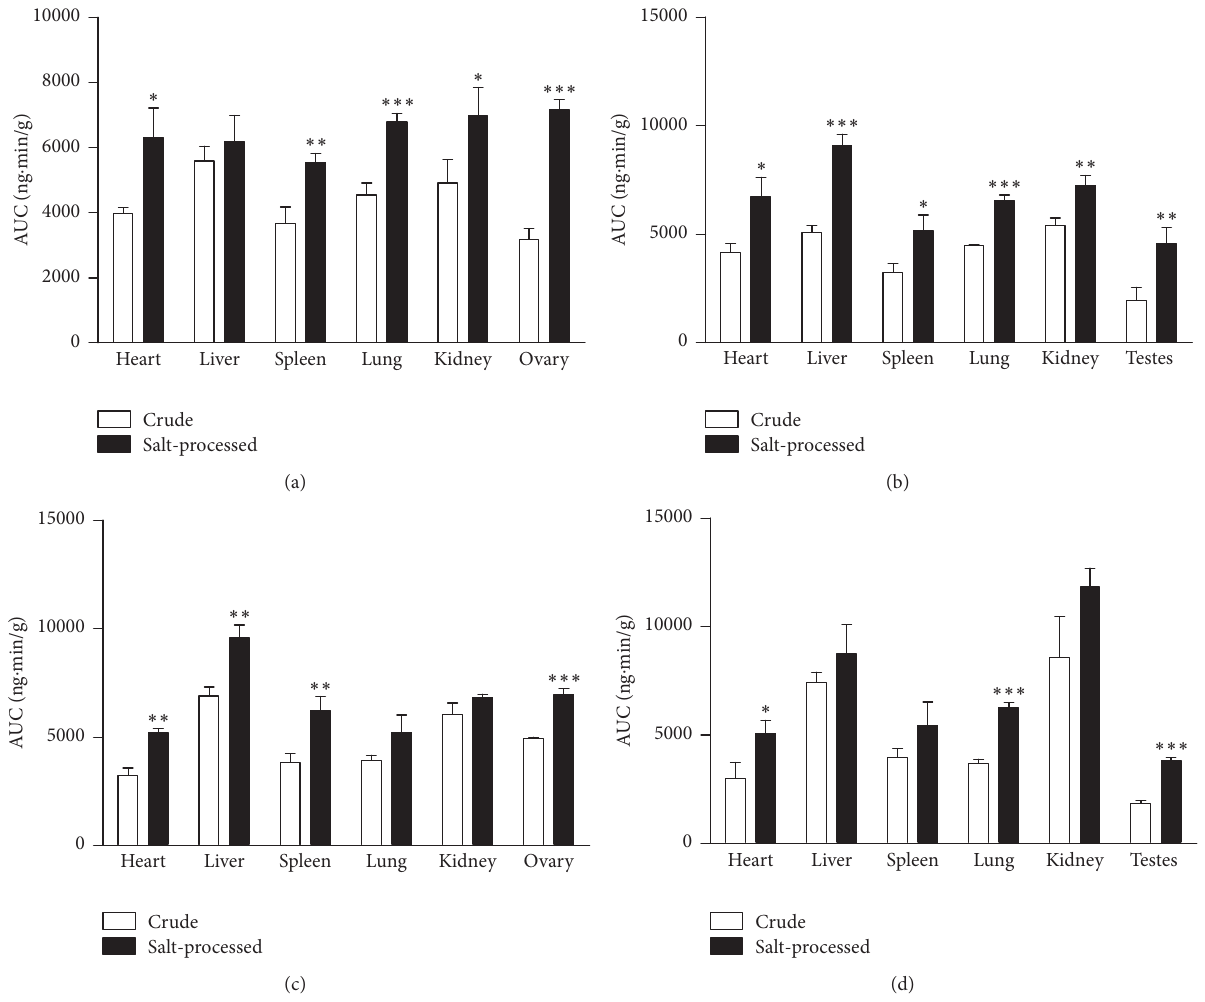
Figure3:TheAUCprofilesofmainingredientofscurfpeafruitinrattissues.(a)Psoraleninfemalerat;(b)psoraleninmalerat;(c)isopsoralen in female rat; (d) isopsoralen in male rat. Salt-processed group compared to crude group; ∗ 𝑝 < 0.05 ; ∗∗ 𝑝 < 0.01 ; ∗∗∗ 𝑝 < 0.001